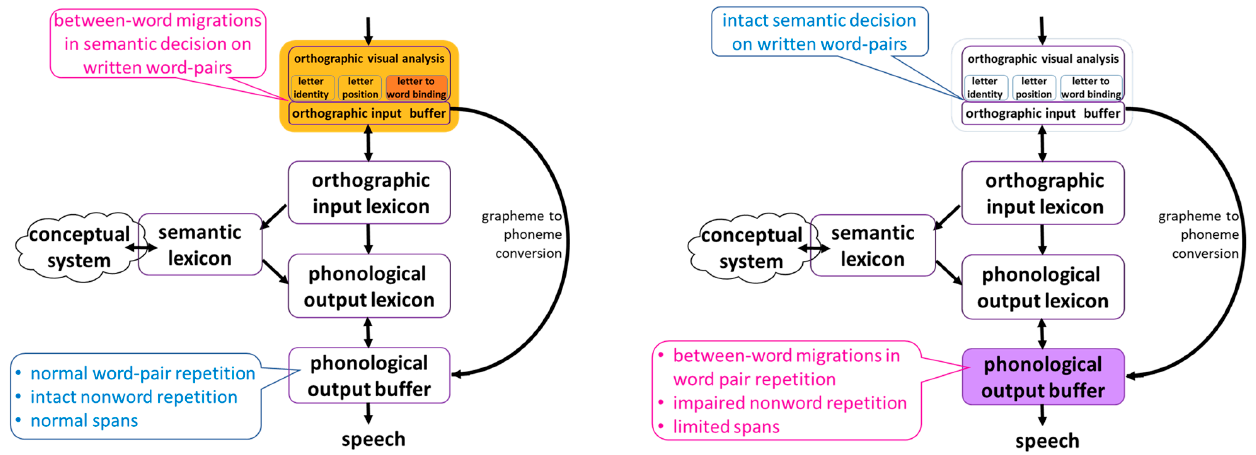
Figure 4. The impaired (cherry red) and intact (blue) performance in the input and output tasks of the participants of the two groups who showed between-word migrations in the oral reading of word pairs: the orthographic input deficit group (left), and the POB deficit group (right).